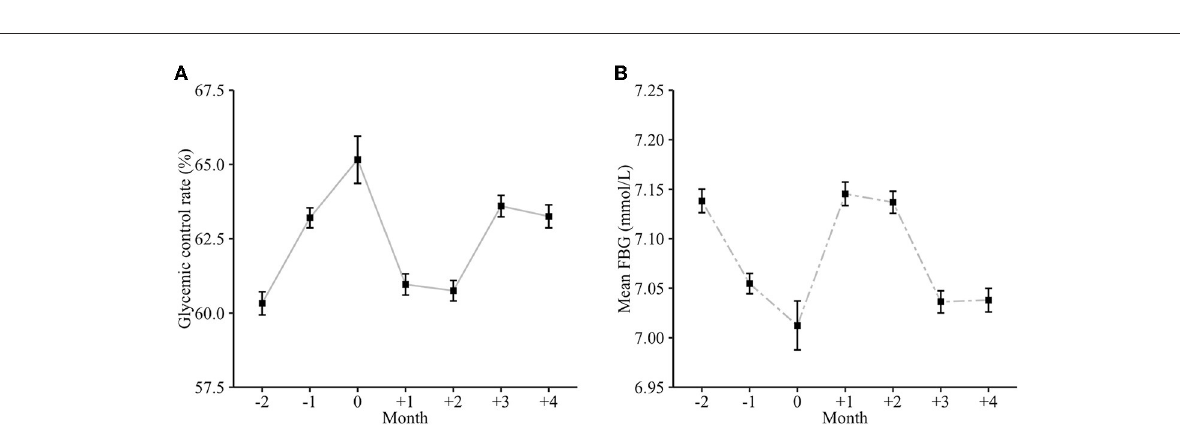
performed using R version 4.0.3 (10 October 2020). All